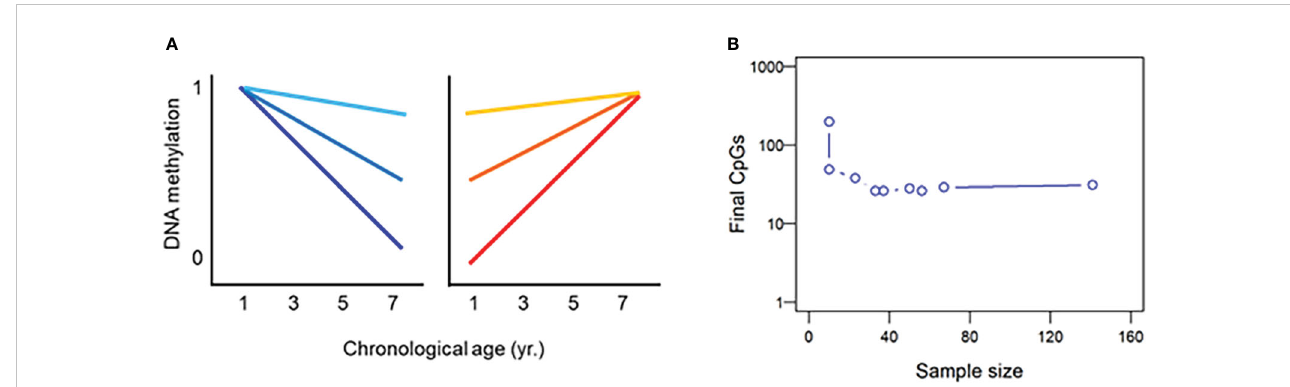
FIGURE 2 Principles behind the development of epigenetic clocks. (A) There are some CpG loci the methylation of which is of a clock nature becoming progressively hypo- (blue) or hypermethylated (red) in different degrees. (B) Relationship between sample size and number of informative loci in the piscine epigenetic clocks developed so